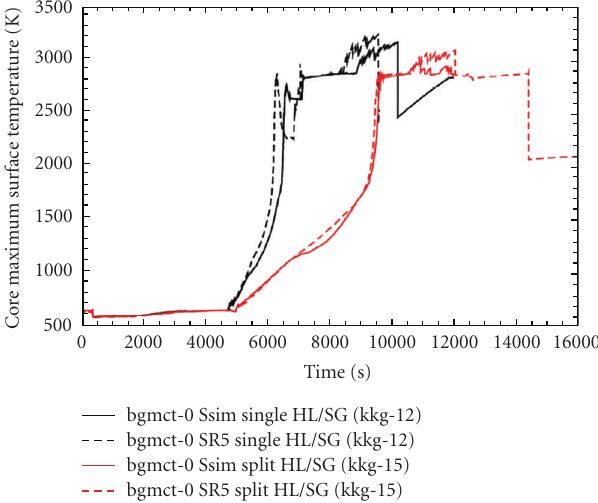
Figure 12:Example ofRELAP/SCDAPSIM and RELAP/SCDAPSIM- calculated results for peak core temperature for single and split hot leg